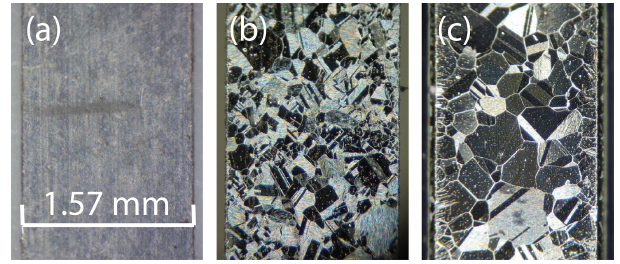
Figure 14. Optical image of permalloy grains (a) before heat treat- ment and after heat treatment at (b) 1150 ◦ C and (c) 1200 ◦ C.